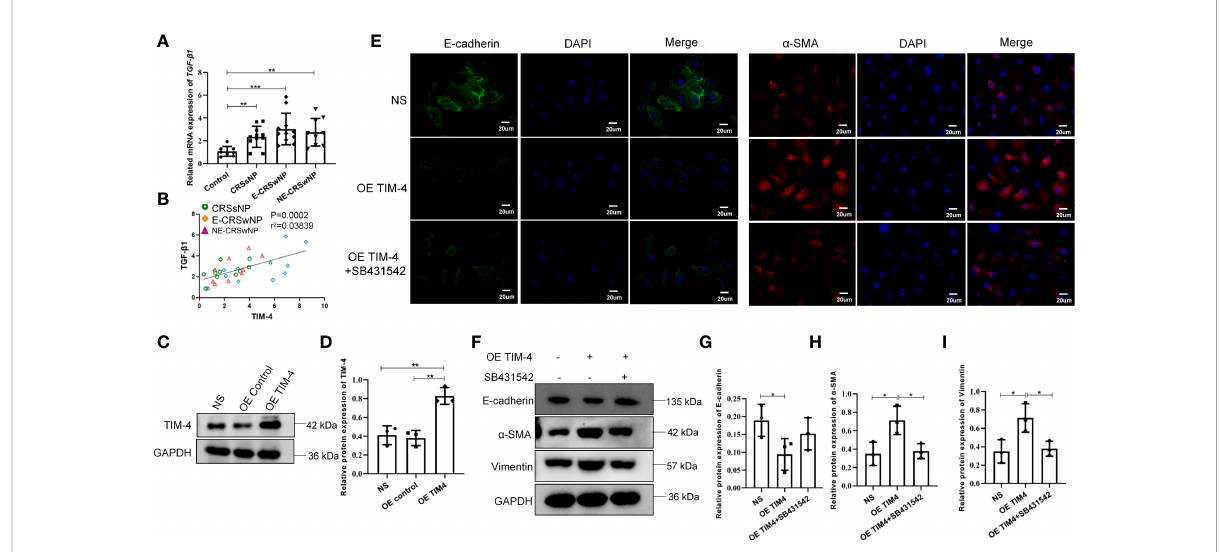
FIGURE 5 TIM-4 expression in macrophages contributes to EMT of nasal epithelial cells. (A) The mRNA expression levels of TGF- b 1 in different human sinonasal mucosa, as detected by quantitative RT – PCR. (B) The correlation between TIM-4 and TGF- b 1. (C) TIM-4 overexpression in THP-1 cells was measured by Western blot analysis. GAPDH was used as a control. (D) Quantitative summary of the relative protein expression of TIM-4. (E) hNECs were cultured with OE TIM-4 THP-1 cells transfected with lentivirus and treated with 10 m mol/L TGF- b 1 inhibitor (SB431542) for 24 h. The expression of EMT markers E-cadherin and a -SMA was detected by immuno fl uorescence. (F) The OE TIM-4 THP-1 cells and RPMI2650 were cocultured and treated with 10 m mol/L TGF- b 1 inhibitor (SB431542) for 24 h, and the expression of EMT markers E-cadherin, a -SMA, and Vimentin were detected by Western blot analysis. The intensity values of the bands were normalized to GAPDH expression. (G) Quantitative summary of the relative protein expression of E-cadherin. (H) Quantitative summary of the relative protein expression of a -SMA. (I) Quantitative summary of the relative protein expression of Vimentin. Bars show the mean ± SD. *P<0.05, **P<0.01, ***P<0.001. Representative immuno fl uorescence images are shown at 400× magni fi